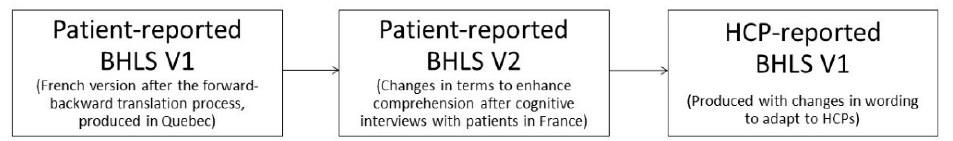
Figure 1. Development of the different versions of the BHLS used in this study.